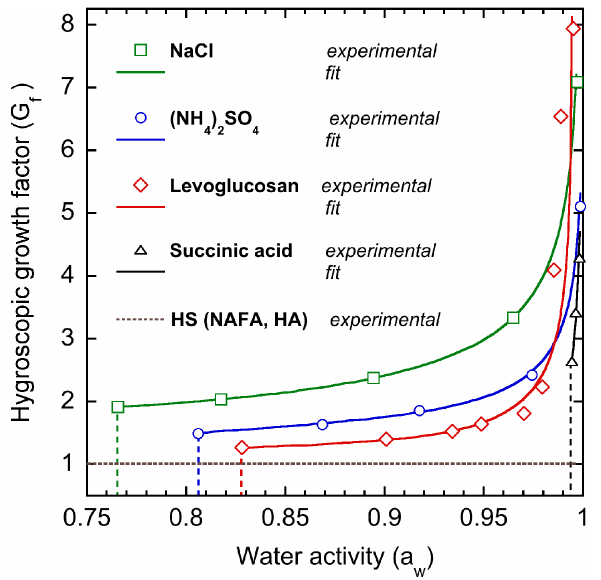
Fig. 6. Hygroscopic growth factor as a function of water activity for the NAFA–LEVO mixture at 25 ◦ C. Solid symbols show growth factors calculated from bulk solution measurements using Eq. (3). The solid line represents the fit to the data based on the water activ- ity parameterizations presented in Table 1. The dashed line denotes the hygroscopic growth factor as predicted by the ZSR method. The curve for pure levoglucosan (dotted line) is given for